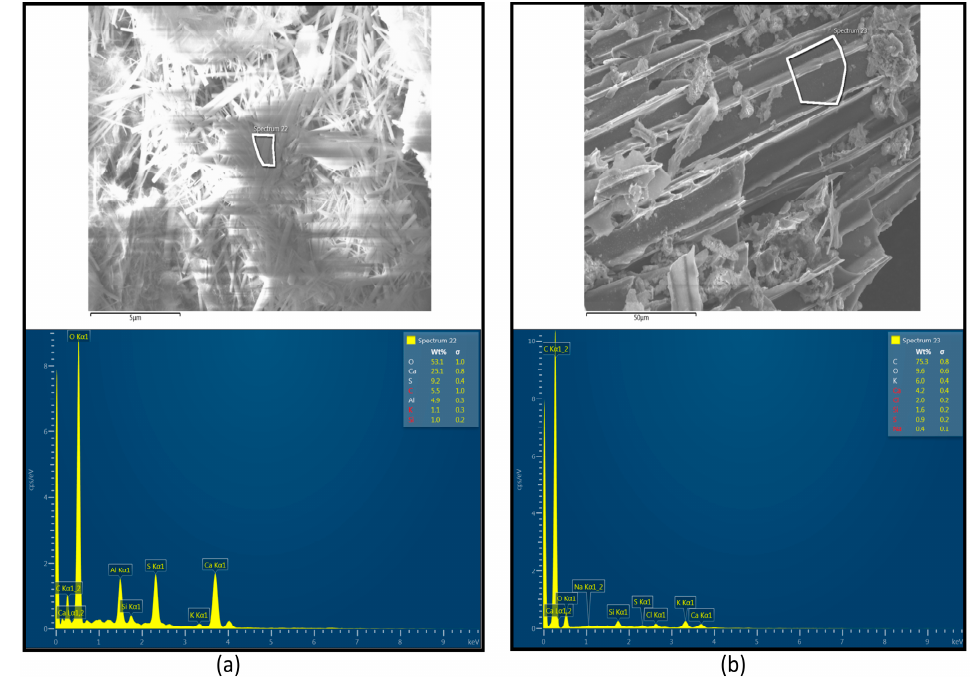
Figure 5. EDS spectrum: ( a ) Whisker; ( b ) Coke dust particle.